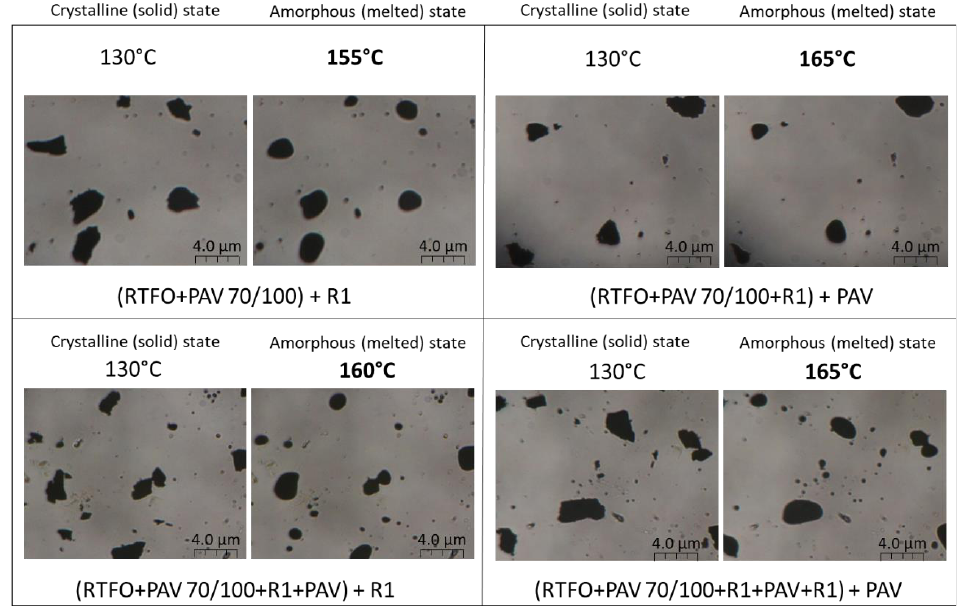
Figure 6. Light microscopy images indicating asphaltene melting points of R1-modified and aged 70/100 bitumen.